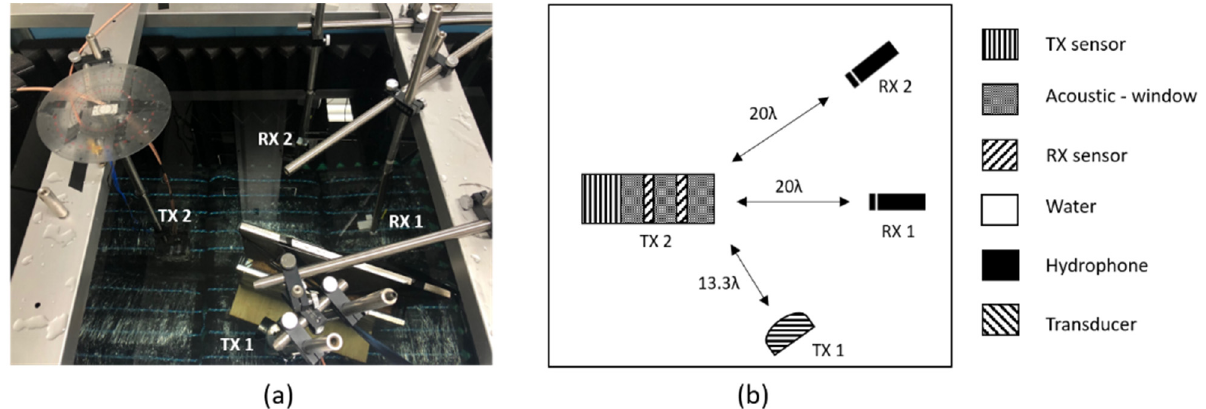
Figure 9. Experimental setup: ( a ) actual setup; ( b ) schematic of the experimental setup.